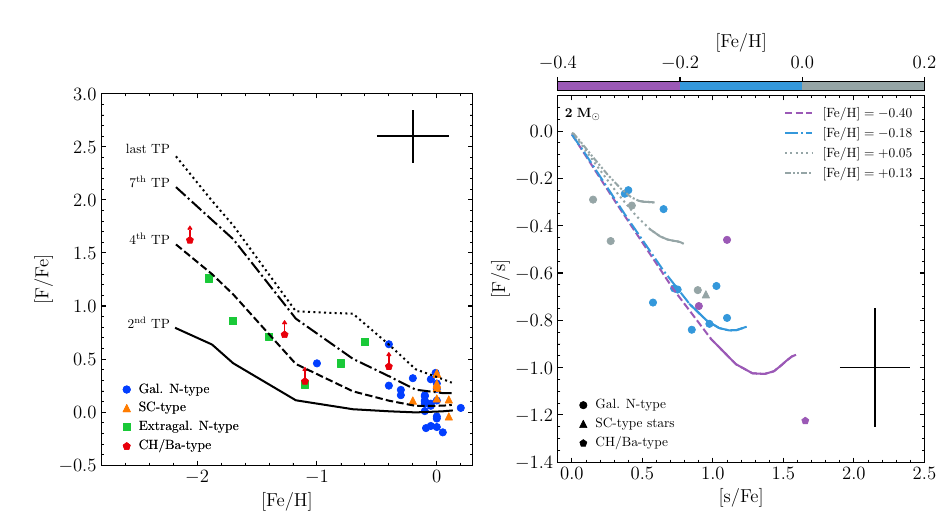
Figure 1. (Left panel) Comparison between observed [F / Fe] ratios as a function of the metallicity and FRUITY magnetic models. Symbols refer to four data groups: circles, galactic (N-type) carbon stars; triangles, SC-type stars; squares, extragalactic carbon stars; pentagons, extrinsic CH / Ba stars. Lines represent theoretical predictions for 2 (for [Fe / H] ≥ − 0 . 7) and 1.5 M (cid:12) (for [Fe / H] < − 0 . 7) AGB stars at di ff erent thermal pulses (TPs). (Right panel) Observed [F / s] vs. average s-element enhancements compared with theoretical predictions for 2 M (cid:12) and close-to-solar metallicity models. Data points and theoretical lines are color-coded by [Fe / H]. The solid portion of the lines represents the theoretical C-rich phase, while the dashed portion represents the O-rich phase. Typical error bars are